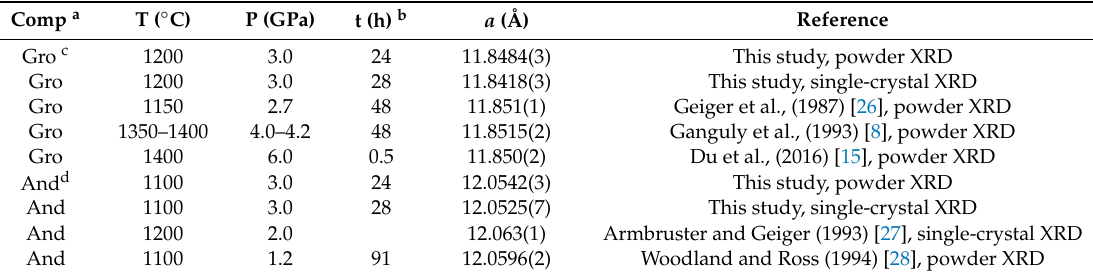
Figure 3. Effect of composition (x) on ( a ) unit-cell parameters and ( b ) unit-cell volume of grossular–andradite solid solution. The equations shown are fitted by least-squares analysis.